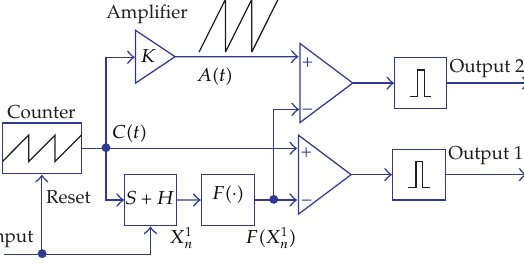
Figure 2: Scheme for the